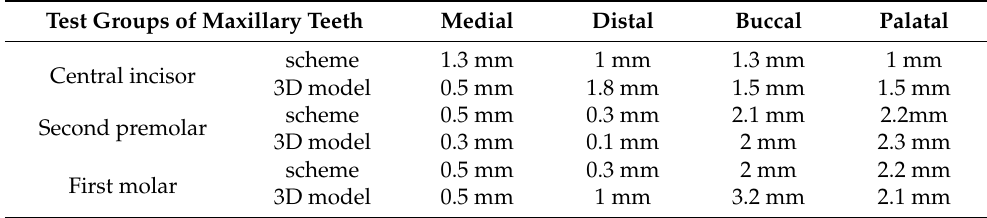
Table 2. Measurements of remaining thickness of the ceramic walls around the implant abutment on the scheme and on the 3D model slices. Critical areas possessing a thickness of less than 0.5 mm are considered to pose a high risk of fracture.